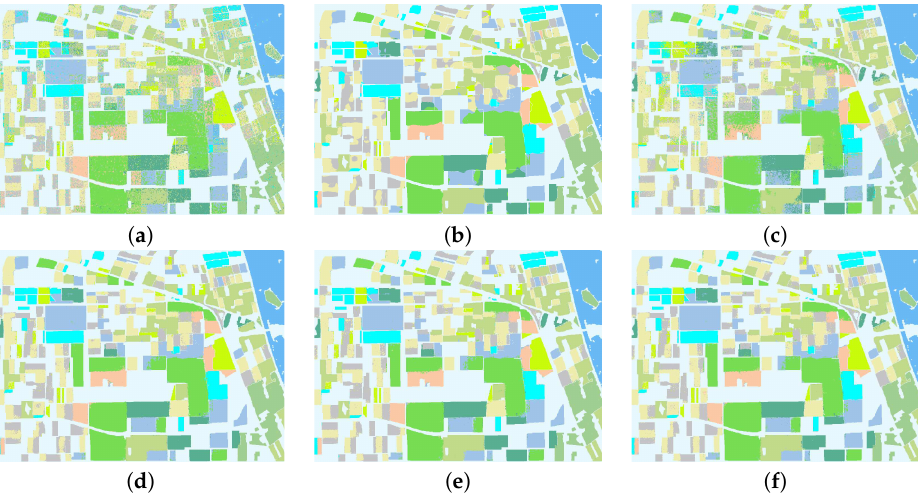
Figure 17. Classification maps resulting from the Flevoland data set with different